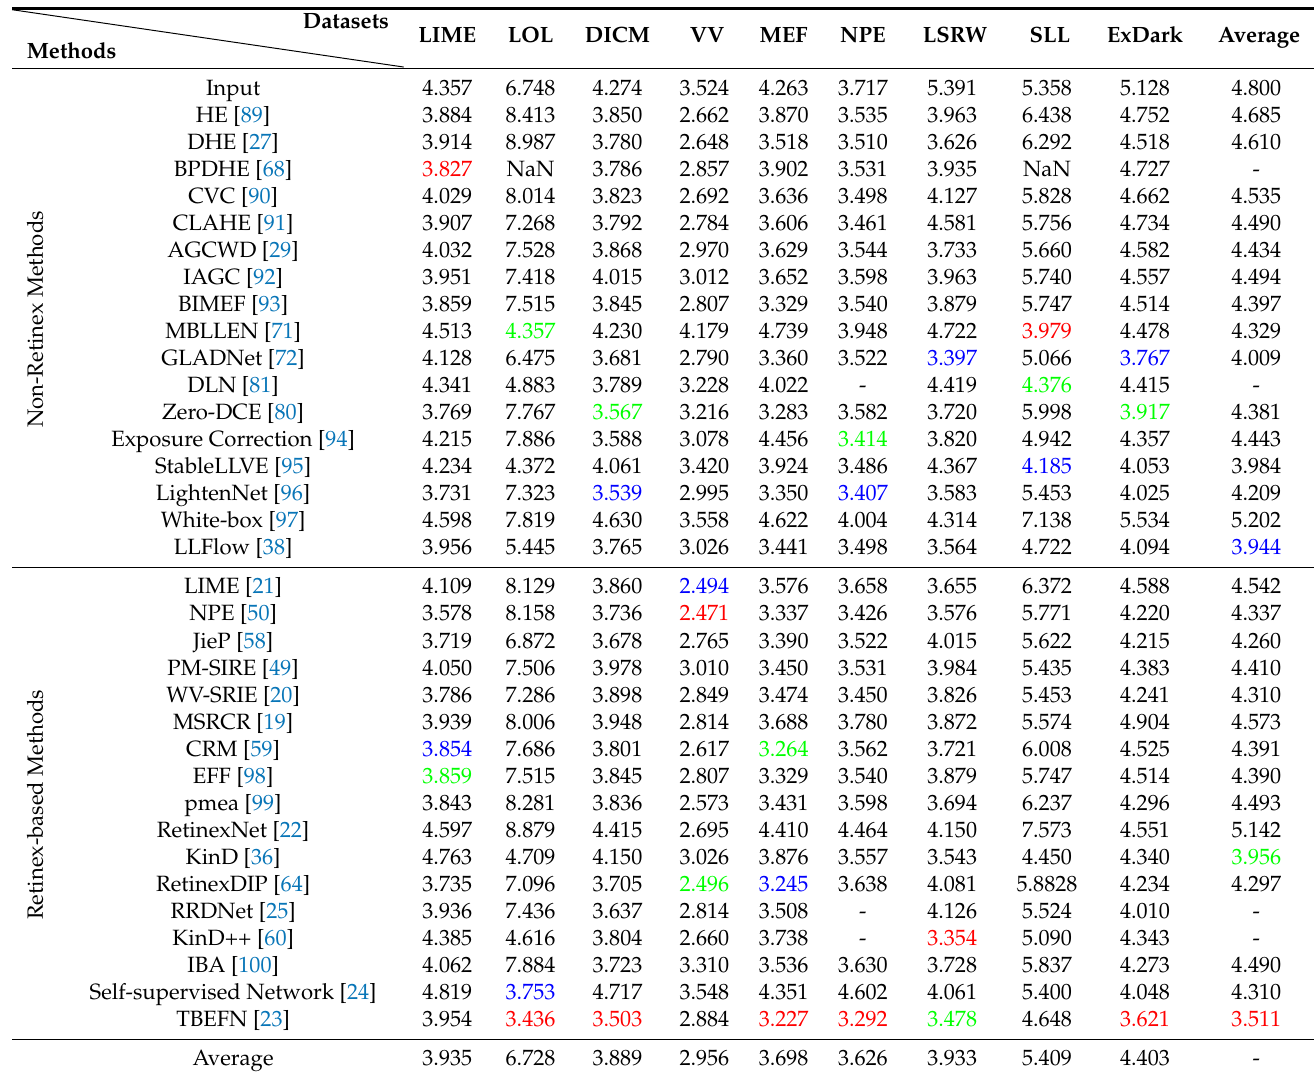
Table 2. Quantitative comparison of enhancement algorithms on nine test datasets using NIQE metric. A lower value of the NIQE metric indicates better performance. The first, second, and third best scores are highlighted with red, blue, and green colors,